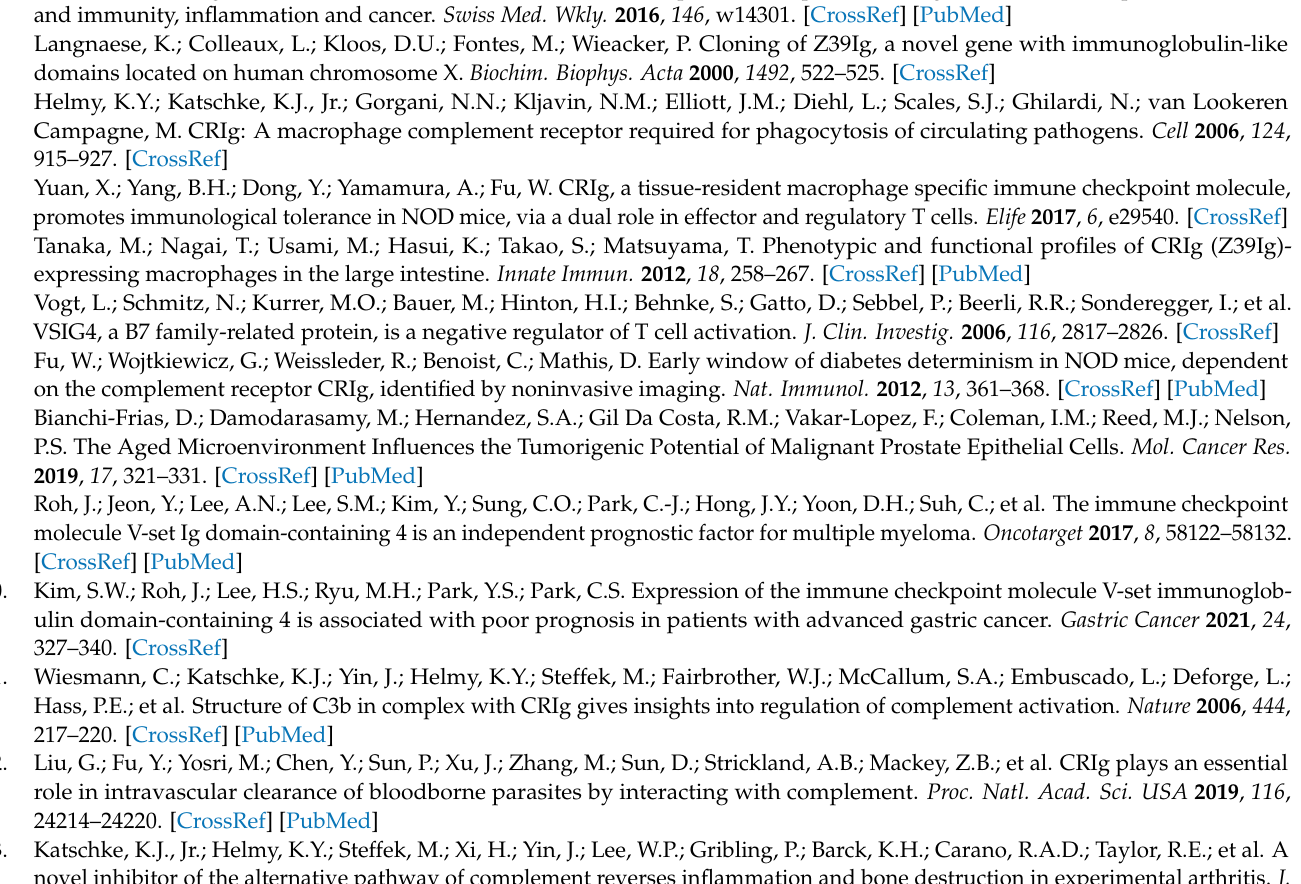
analysis on Phylum and Genus level, Figure S4: Ct curve, Figure S5: The recovery of the intestinal flora. Table S1: Primers and the data of PCR